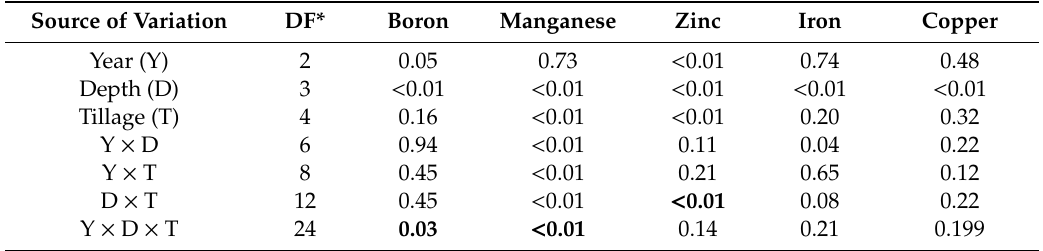
Table 1. ANOVA table of the main and interaction e ff ects of year, treatment, and depth on the concentration Mehlich III extractable B, Mn, Zn, Fe, and Cu in the wheat–pea rotation long-term experiment.